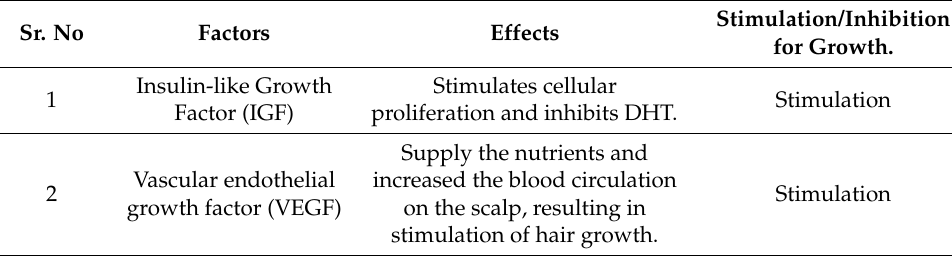
Figure 4. Factors affecting gene expression. Table 2. The factors acting on a hair growth cycle.